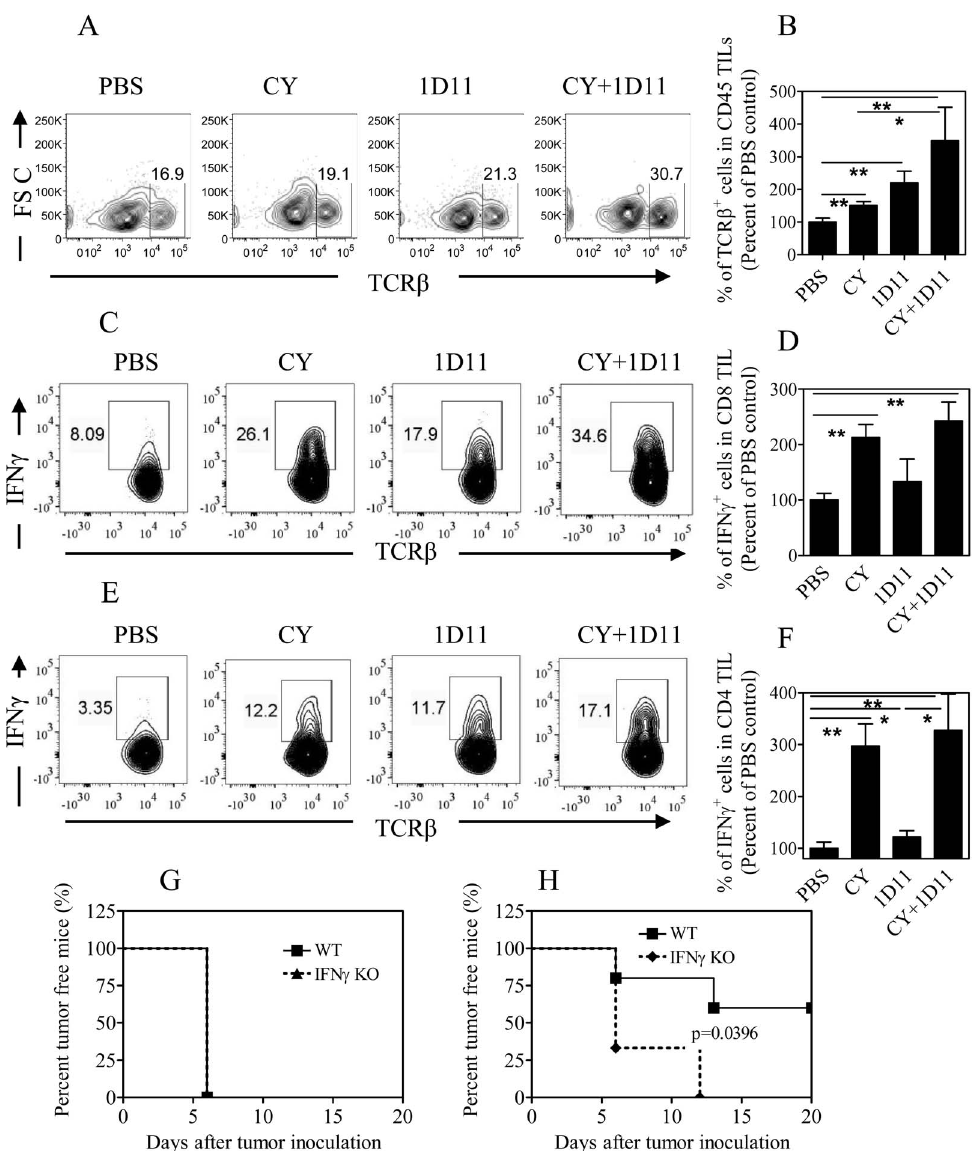
Figure 4. Combination treatment of 1D11 and CY promotes tumor infiltration of IFN c -producing T cells. Four weeks after 4T1 tumor inoculation, cell suspension was prepared from tumor tissues. (A-B) Proportion of TCR b + T cells in total tumor infiltrating CD45 + leukocytes. Typical flow plots are shown in (A), and summary of data from three separate experiments is shown in (B, Means 6 SEM, N=14 , 20). (C-F) IFN c expression by CD8 and CD4 TILs. Intracellular expression of IFN c was analyzed by FACS, gating on live CD45 + TCR b + CD8 + cells (C-D) or CD45 + TCR b + CD4 + cells (E-F). Data shown are typical FACS plots (C, E) and summary of data (D, F) from three separate experiments (Means 6 SEM, N=9). Comparison of indicated groups, * p , 0.05, ** p , 0.01. ( G, H ) Normal WT Balb/c mice and IFN c KO mice were inoculated with 4T1 cells and treated with 1D11 + CY in the same manner. (G) Incidence of 4T1 tumor in mice treated with PBS. (H) Incidence of 4T1 tumor in mice treated with 1D11 and CY. Data are shown as percent tumor free mice (%, KO mice N=3, WT mice N=5), which are representatives of two separate experiments with similar